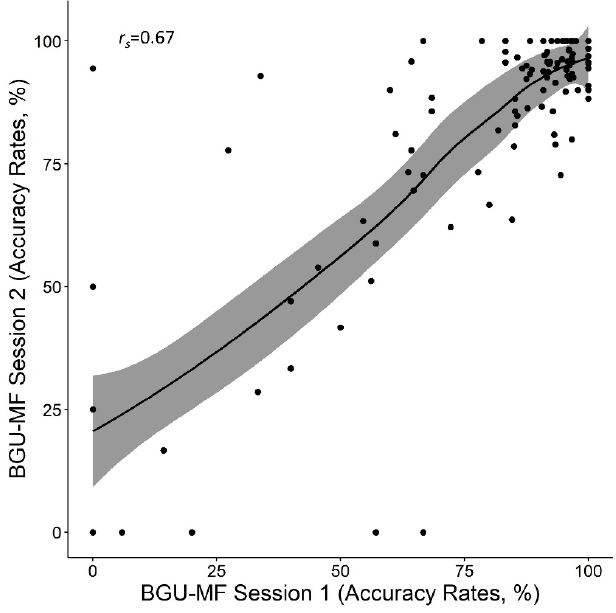
Figure 3. Correlation between accuracy rates in the first and second sessions in the BGU ‐ MF.